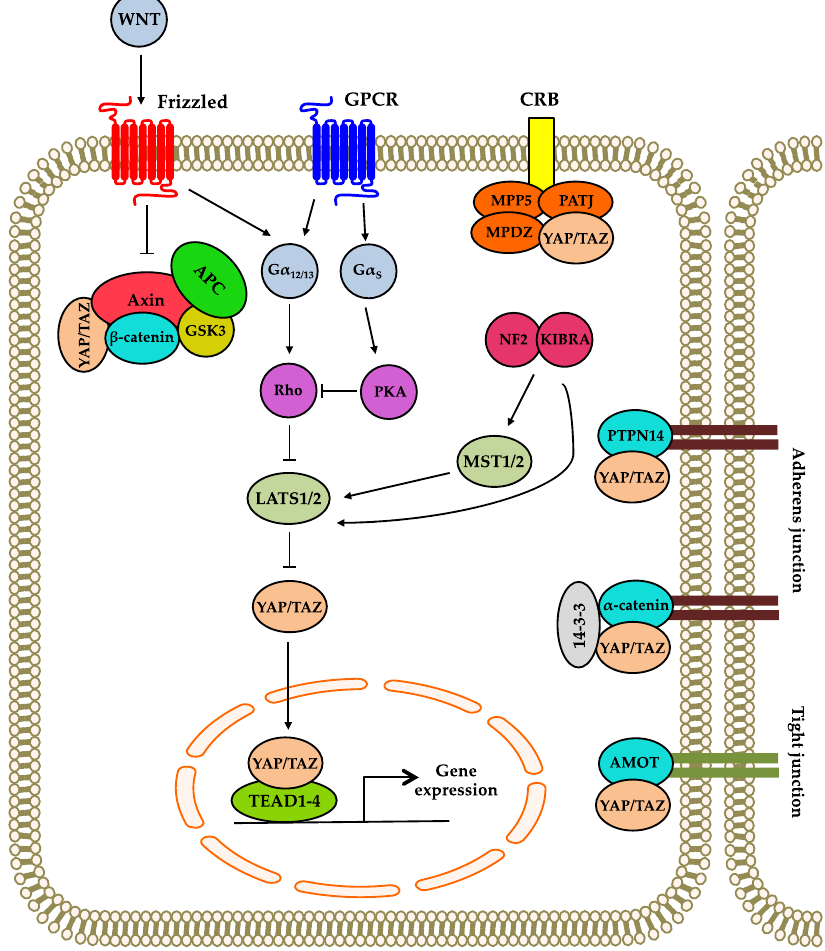
Figure 2. Regulation of the Hippo signaling pathway in mammalian cells. The Hippo pathway is regulated by several upstream regulators: (1) proteins involved in cell polarity; (2) WNT and GPCR signaling; (3) components of the adherens and tight junctions. Pointed arrowheads represent activating interactions, whereas blunt arrowheads represent interactions that are inhibitory. Neurofibromin 2 (NF2) and kidney and brain protein (KIBRA) are important regulators of Hippo signaling, which localize to the apical domain of polarized epithelial cells [30,31]. Earlier